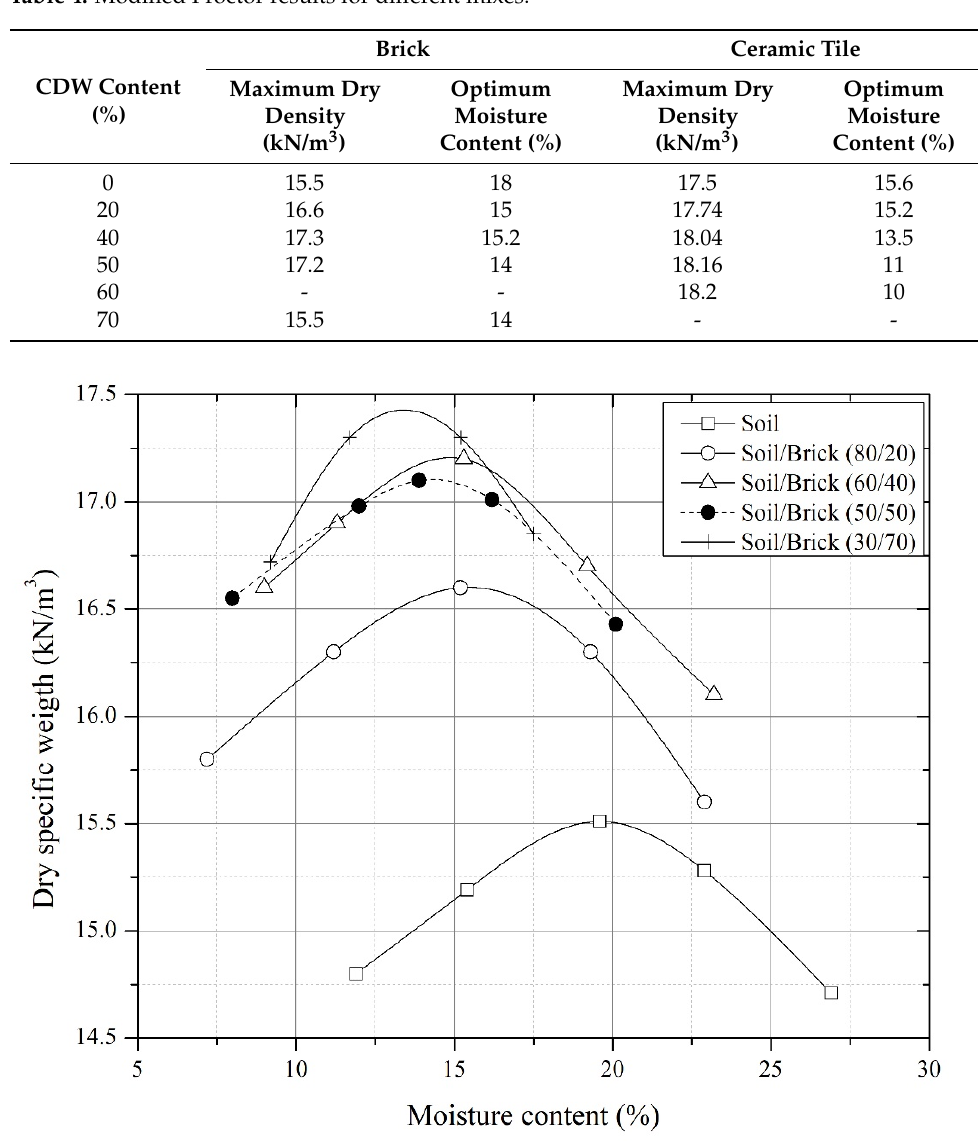
Table 4. Modified Proctor results for different mixes.